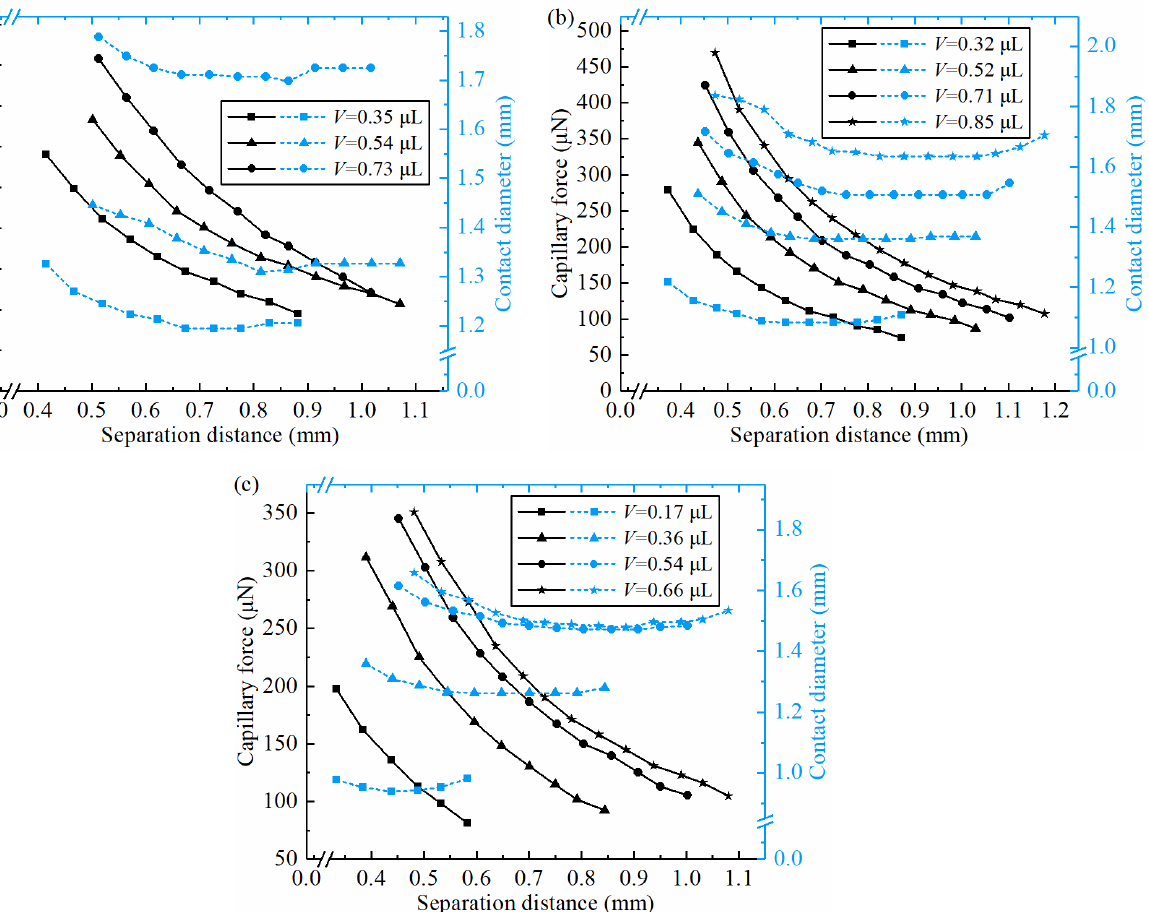
Figure 5. Experimental data: capillary force and contact diameter versus separation distance of different liquids: ( a ) 50 wt% EG, ( b ) EG and ( c ) glycerol.